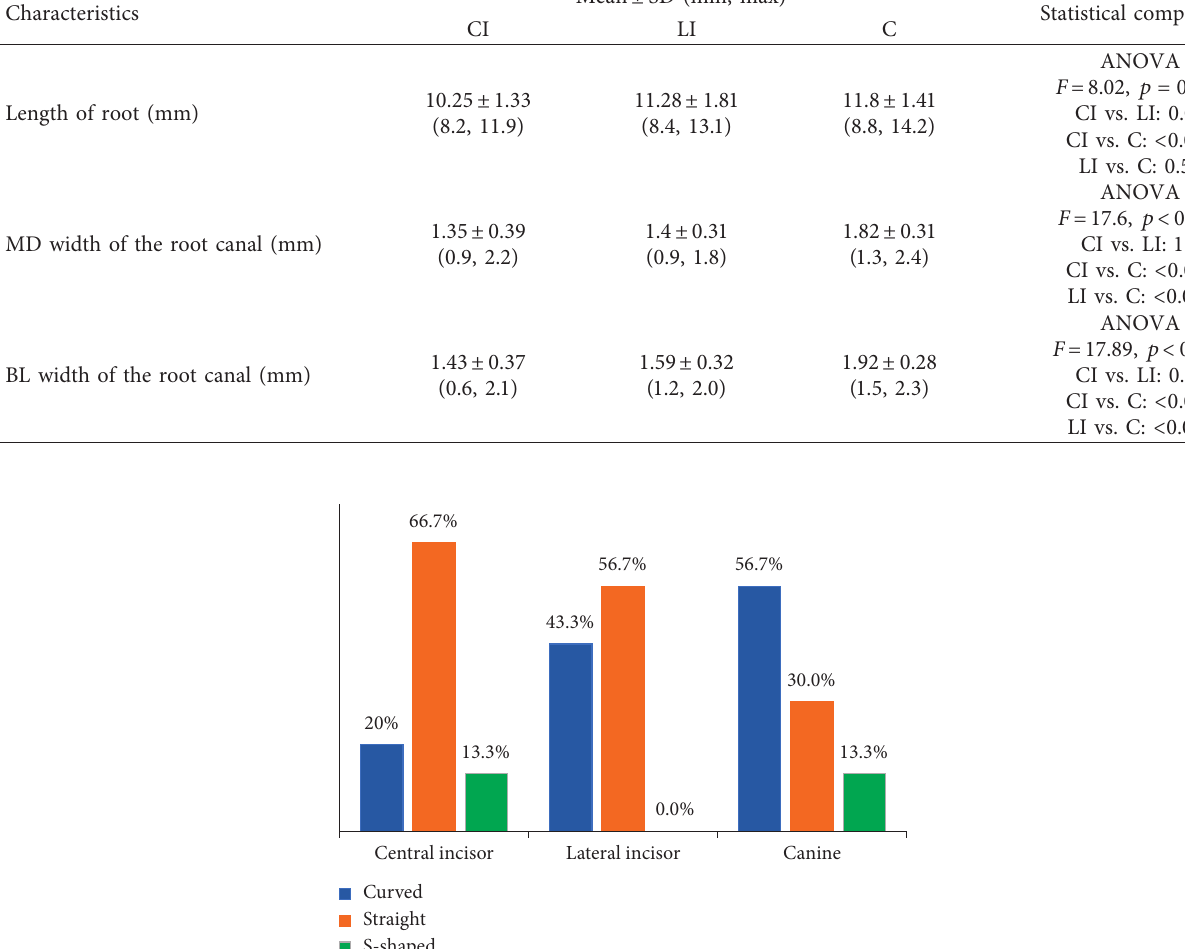
Figure 4: Comparison of shape of root canals between the three